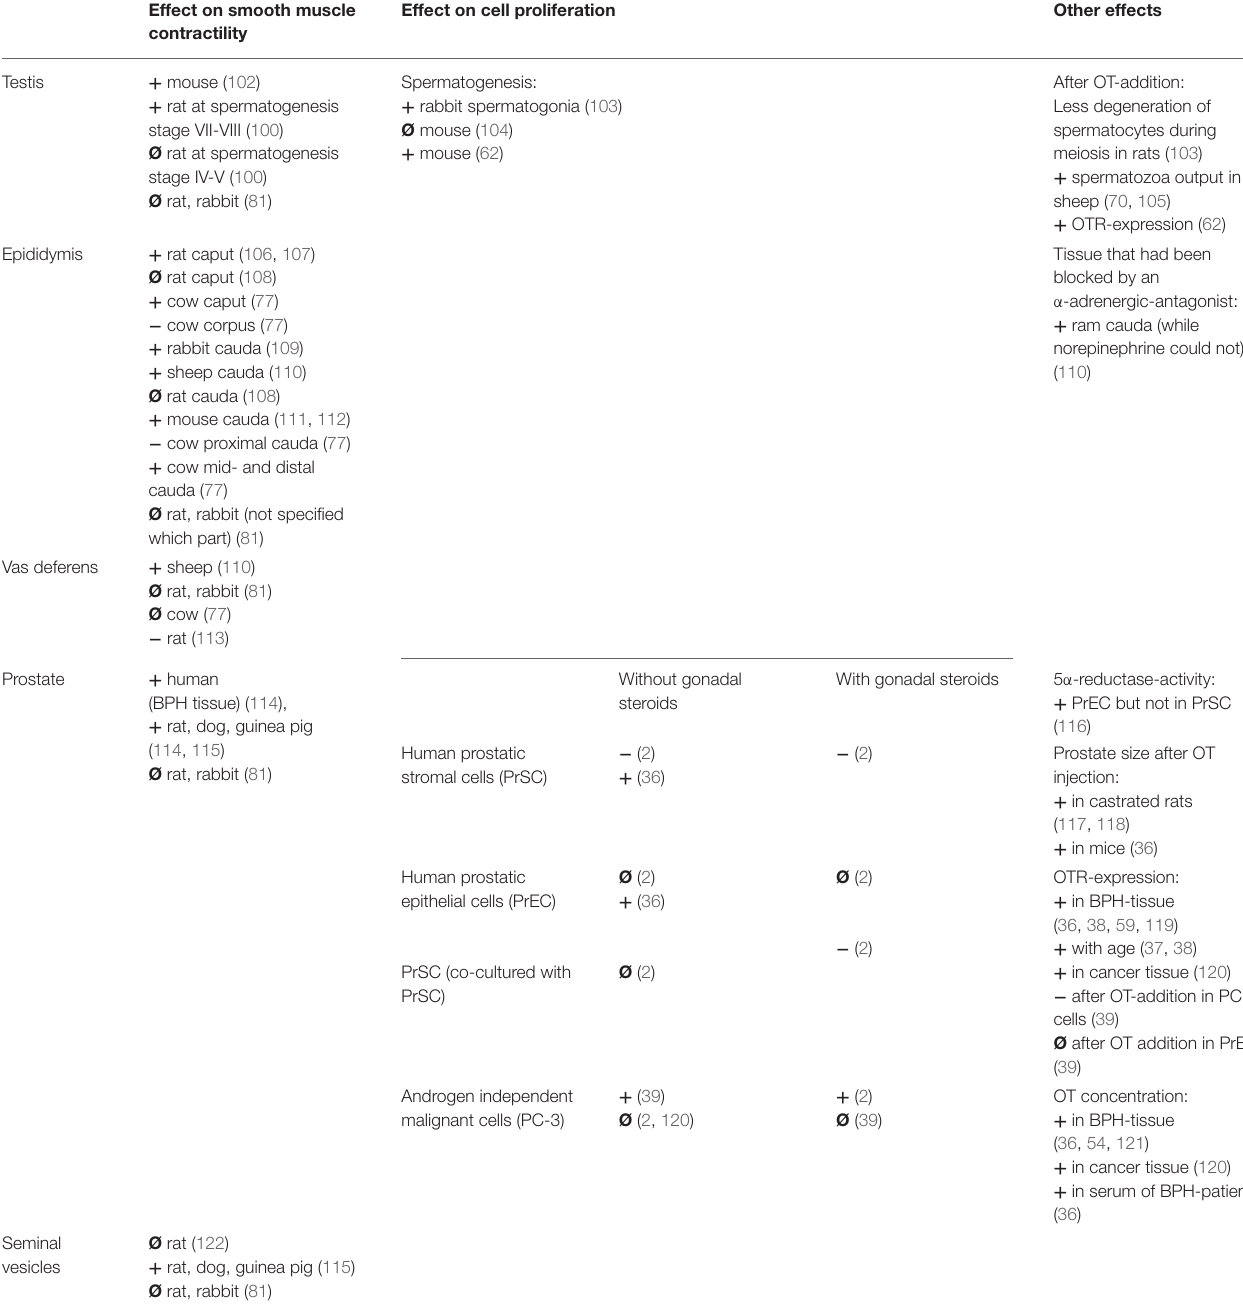
TABLE 2 | Original: Overview of the effect of OT on the male reproductive tract ( + = increasing; − = decreasing; Ø = no